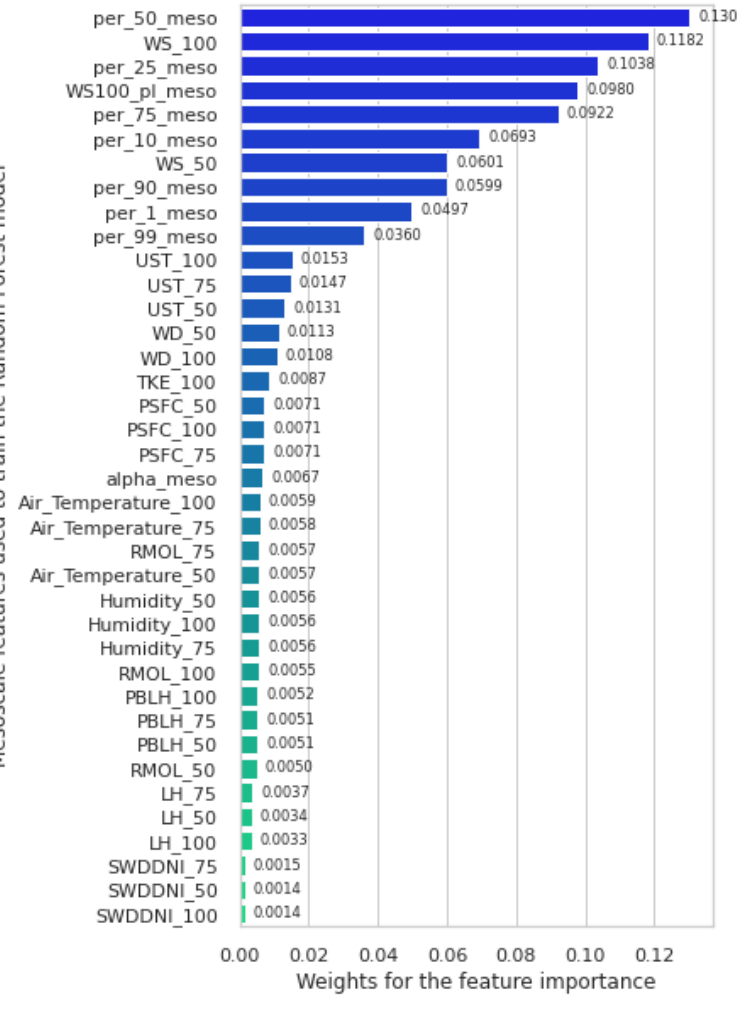
Figure 14. Feature importance for the best model in Scenario A: the random forest. Only mesoscale data for the model training. The sum of all the weights is